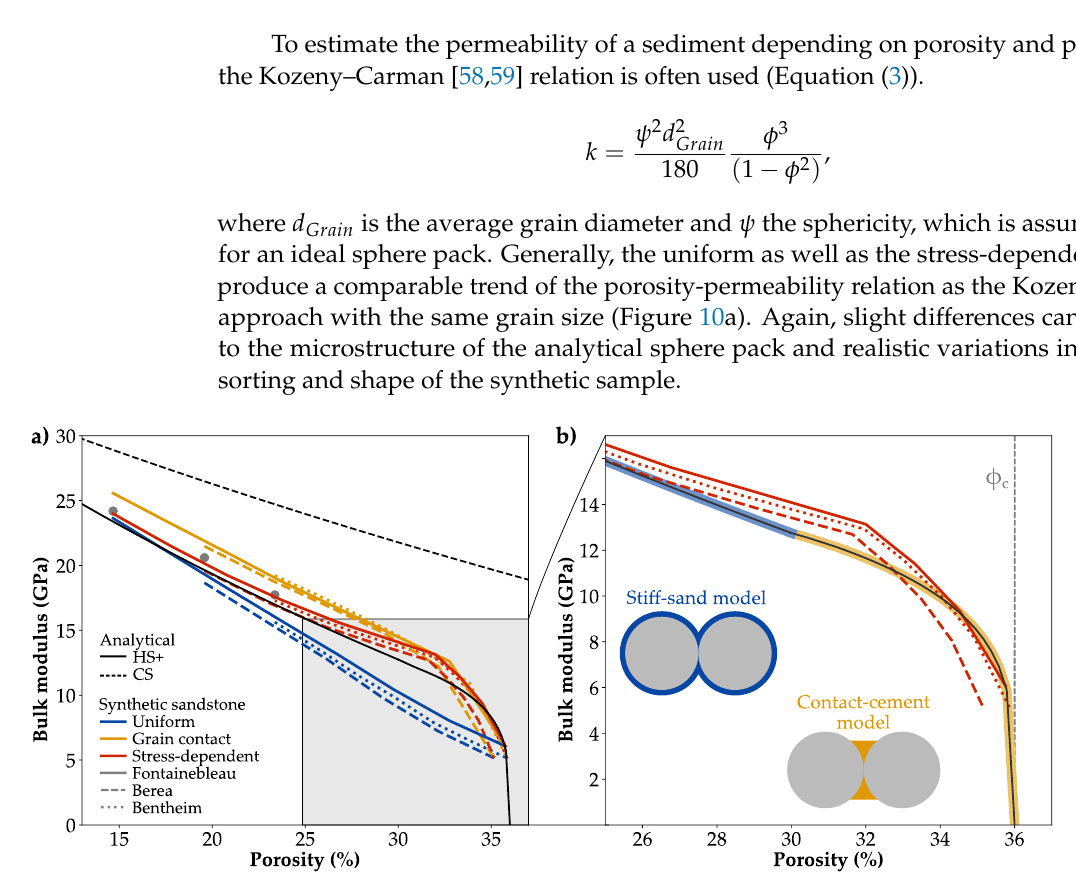
Figure 9. Evolution of the bulk modulus for the three synthetic samples cemented by the uniform (blue), contact- preferential (orange) and stress-dependent scheme (red) ( a ) compared to analytical solutions (black) as the Hashin-Shtrikman upper bound (HS+) and the combined contact-cement and stiff-sand model (CS). ( b ) Bulk moduli between porosities of 30% and 36% are calculated by the contact-cement model [56], while the stiff-sand model is applied for porosities below 30%.